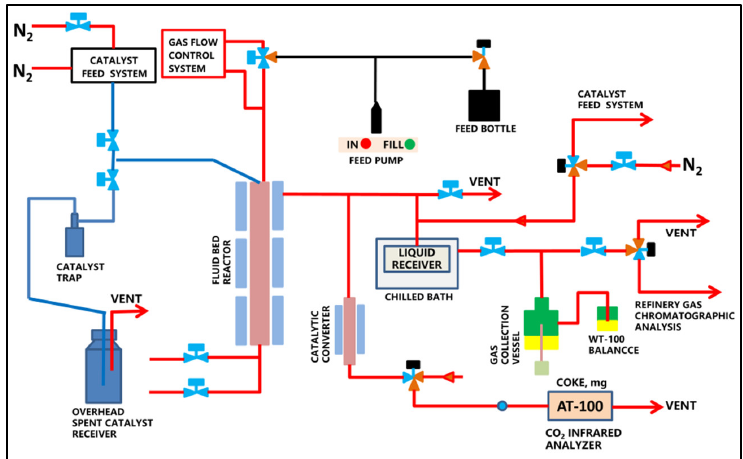
Figure 11. The flowchart of the Advanced Cracking Evaluation (ACE) unit.